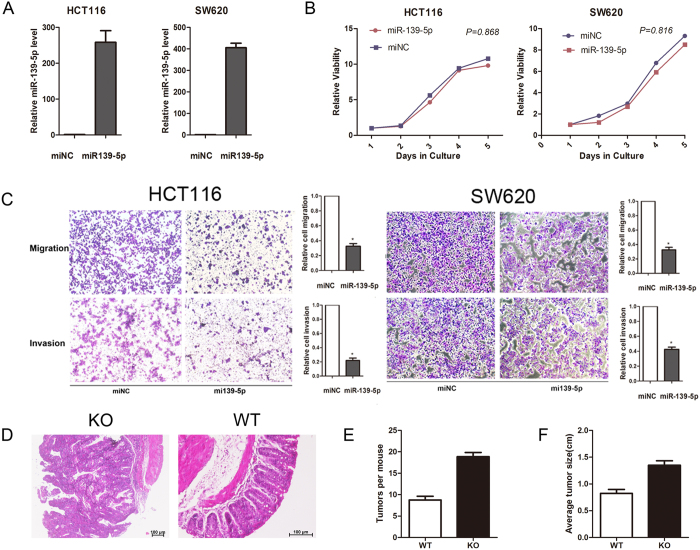
miR-139-5p suppressed colon cancer cells metastasis in vitro and in vivo.(A) The efficiency of miR-139-5p overexpression in colon cancer cell lines was measured by RT-PCR. (B) The influence of miR-139-5p expression on the proliferation of colon cancer cells was measured by CCK-8 assay. (C,D) Representative results of the migration and Transwell assays showing the effect of miR-139-5p expression on the migratory abilities of HCT116 and SW620 cells (unpaired Student’s t-test, mean ± SEM; *P < 0.05). (E) Representative images of tumour differentiation in miR-139-5p KO mice and WT mice. KO mice exhibited poorer tumour differentiation than WT mice. (F) KO mice showed an approximately twofold increase in tumour numbers compared to their WT littermates (unpaired Student’s t-test, mean ± SEM; P < 0.05).